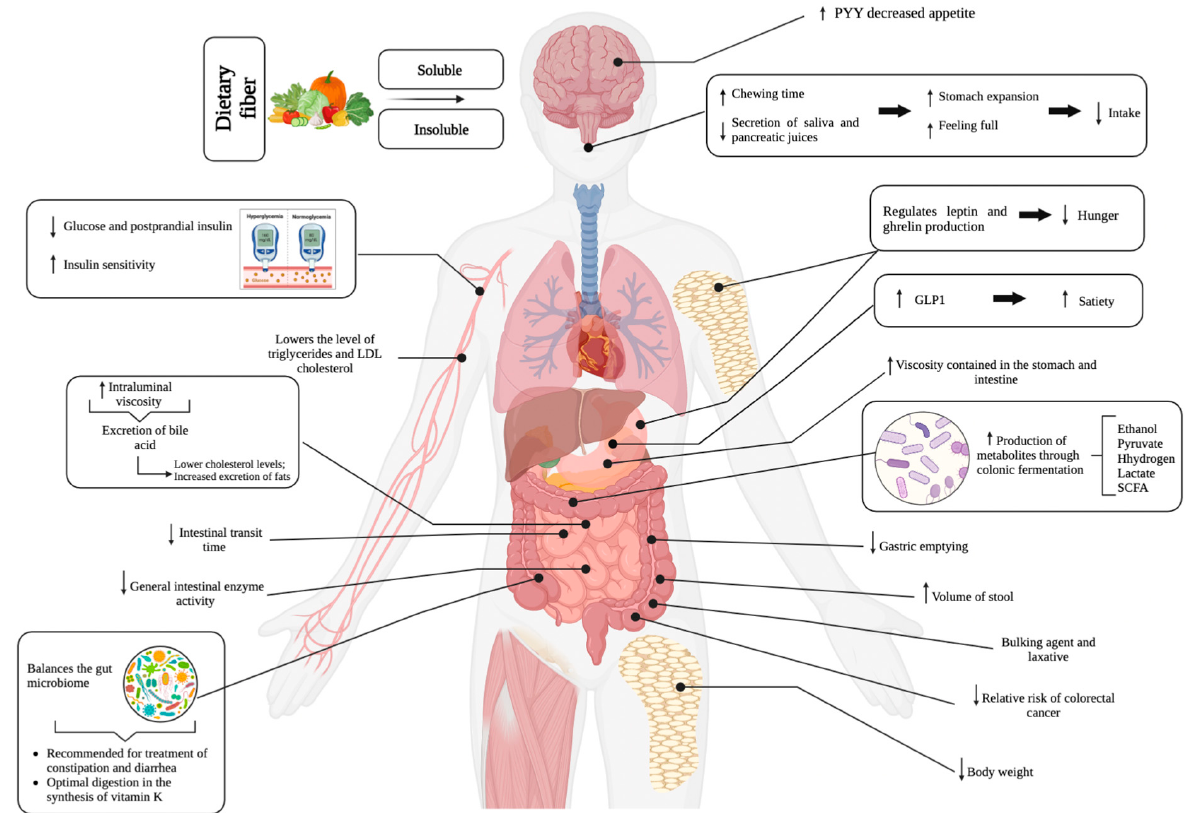
Figure 1. Benefits of dietary fiber consumption on human health. PYY: peptide YY; GLP1: glucagon- like peptide 1; SCFA: short-chain fatty acid. ↑ : increase; ↓ : decreases.